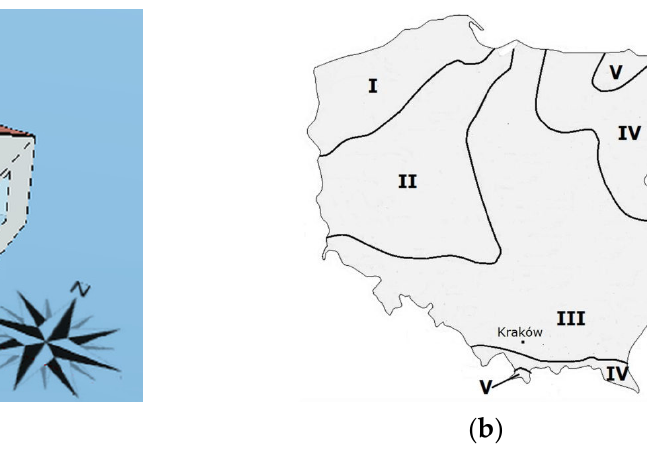
Figure 1. ( a ) Model of the test building; ( b ) location of the building.